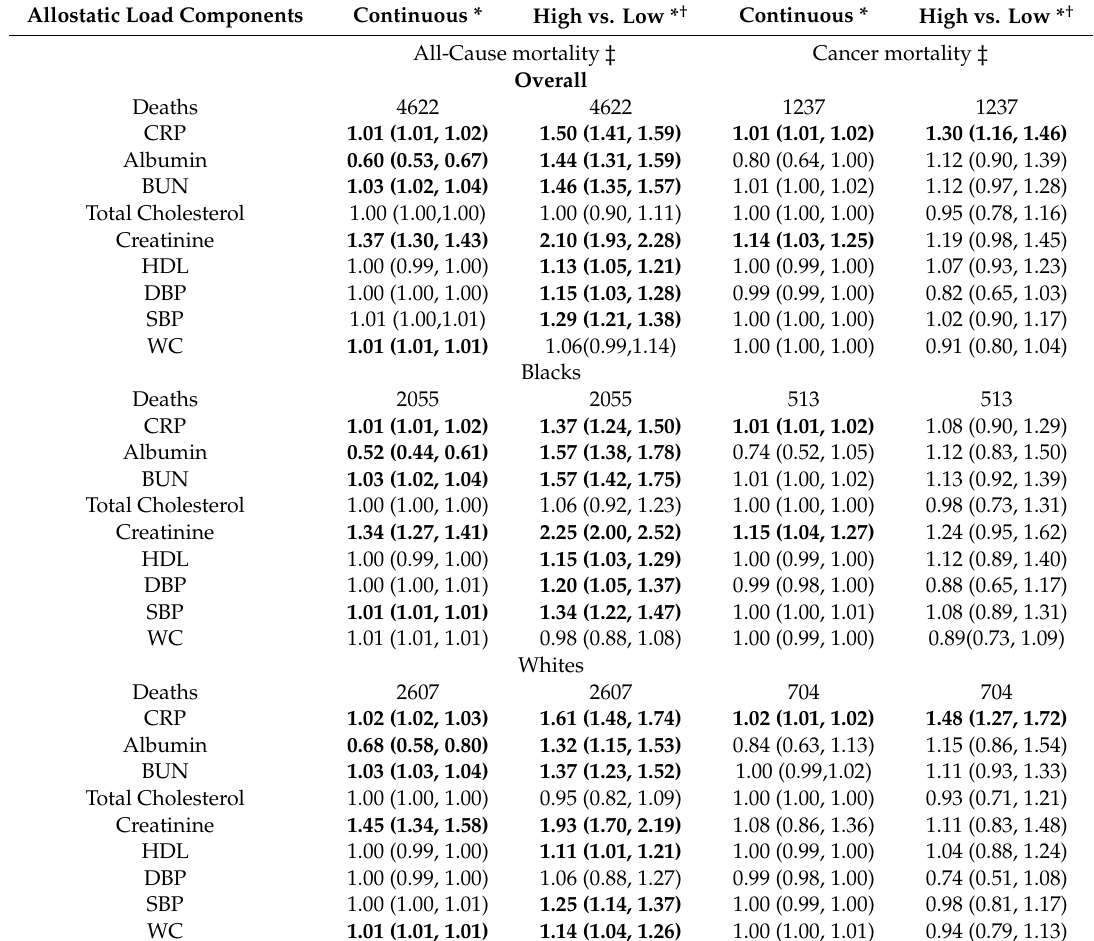
* Model adjusted for demographic covariates, including age, race (except in race stratified models), sex, education, income, smoking status, physical activity level, and alcohol consumption,. † High AL: ≥ 3 biomarkers above threshold. Low AL: < 3 biomarkers above threshold. ‡ Results are presented as HRs and 95% CI. Bold text p -values are below the selected two-sided alpha of